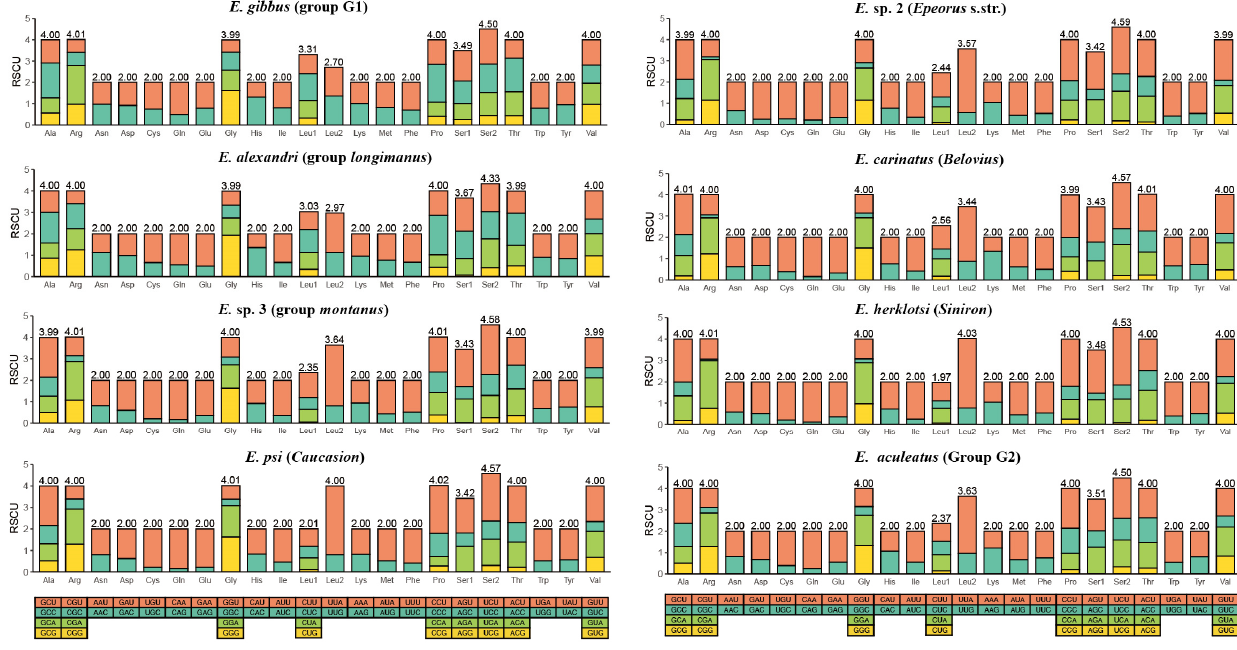
Figure 3. Relative synonymous codon usage (RSCU) of the mitogenomes of eight representative Epeorus species (including all species groups involved in this work) .